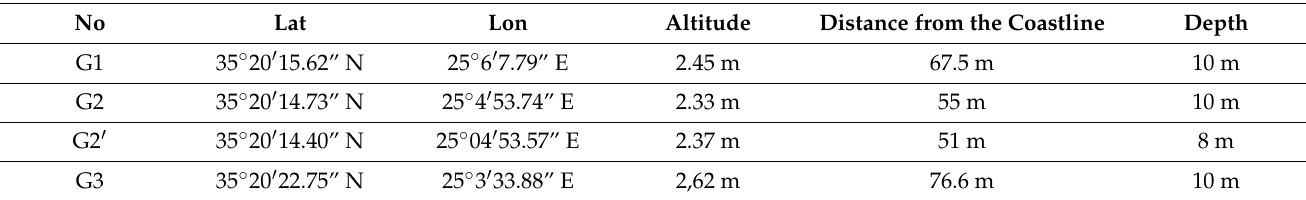
Table 3. Topographical characteristics of the research